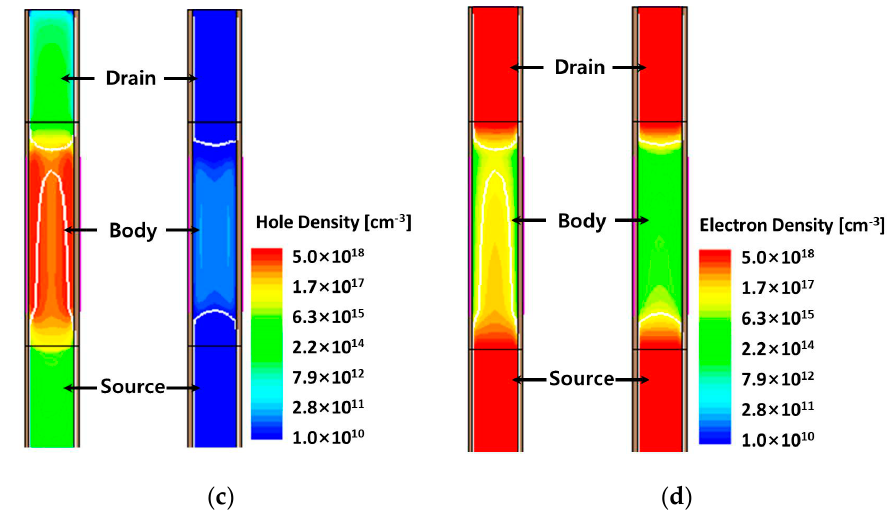
Figure 6. ( a ) A schematic diagram and ( b ) the energy band diagrams for the read ‘1’ and ‘0’ operations. Simulated results for ( c ) the hole density distribution and ( d ) the electron density distribution for the read ‘1’ and ‘0’ operations are also provided. V G_R and V D_R are 0.7 V and 0.1 V, respectively.